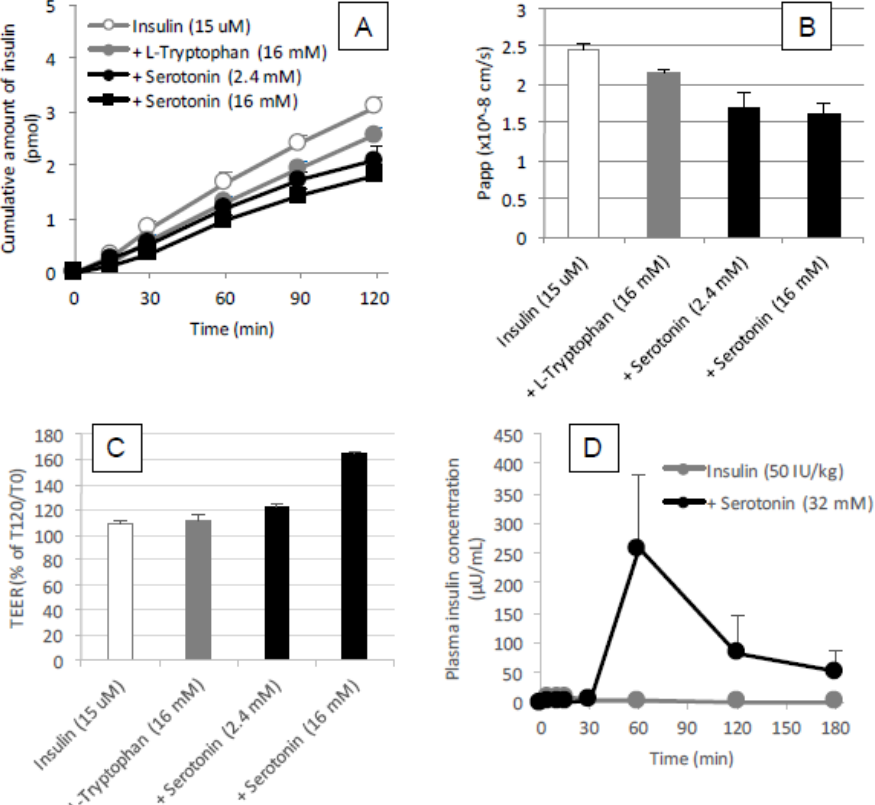
Figure 11. Permeation of insulin through the Caco-2 cell monolayer panels ( A , B ) and TEER values panel ( C ) during coincubation with L -tryptophan (16 mM) or serotonin (2.4 or 16 mM) and the absorption of insulin after its in situ administration of insulin (50 IU/kg) with or without serotonin (32 mM) into rat ileal loop panel ( D ). Each data point represents the mean ± SEM of N = 3.